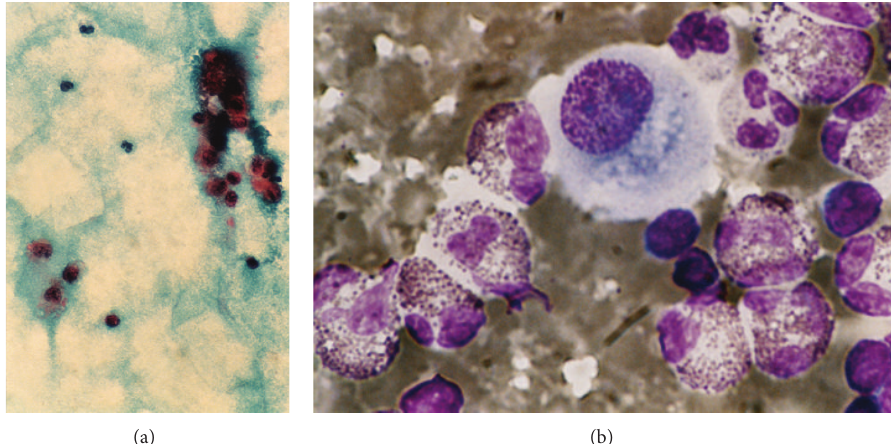
Figure 1: (a) and (b): pleural effusion differential count shows more than 10% eosinophils, Papanicolaou and Wright Giemsa stain, × 400, and oil immersion.